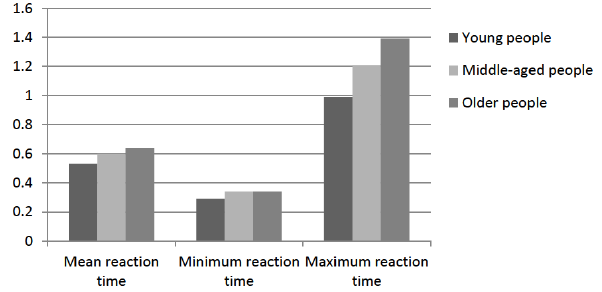
Figure 2: Mean, minimum and maximum reaction times in complex reactions as measured by the test of reaction times (MCR) in the three age groups, N = 95.